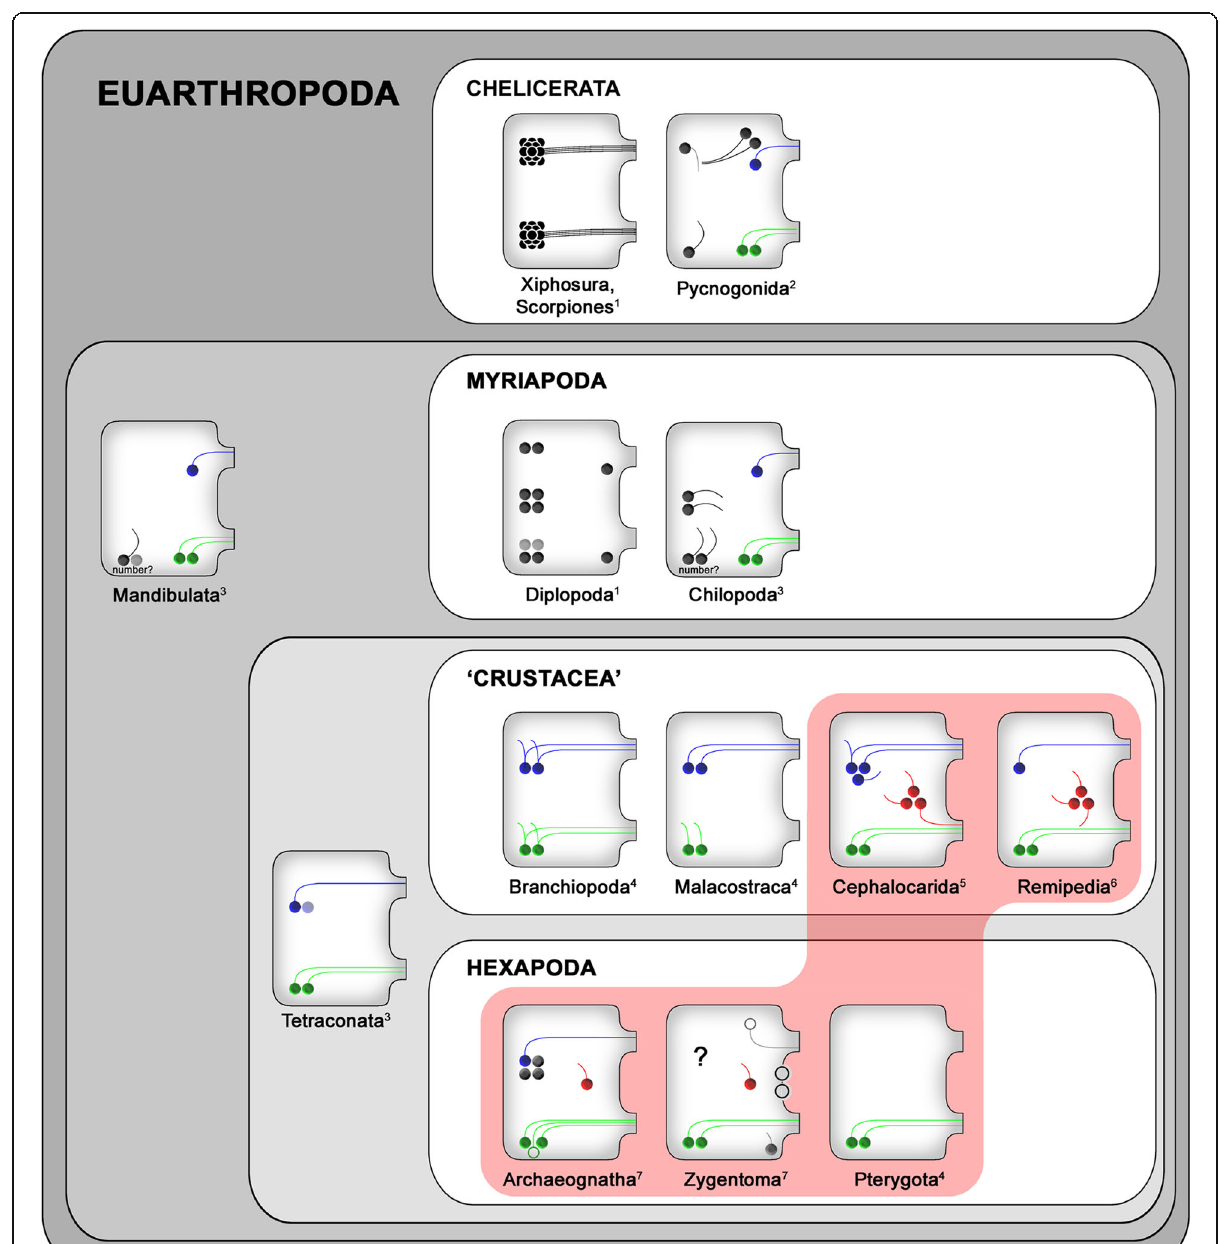
Fig. 7 Patterns of 5HT-ir neurons in ganglia of the VNC for major euarthropod taxa. Blue, red, and green neurons indicate anterior, medial, and posterior somata, respectively. Gray neurons are those somata that cannot unequivocally be assigned to the ground patterns. Open circles in the archaeognathan and zygentoman patterns show neurons that are part of the thoracic but not of the abdominal pattern (see [1] for details). In Zygentoma, identification of anterior serially homologous neurons proved to be impossible due to intra- and interspecific variations in number, projection pattern and cell body size (marked by ‘ ? ’ , compare [1]). Red box encloses taxa, constituting the Miracrustacea (after [48]). Patterns modified from: 1 [22]; 2 [27]; 3 this study; 4 [21]; 5 [23]; 6 [24]; 7